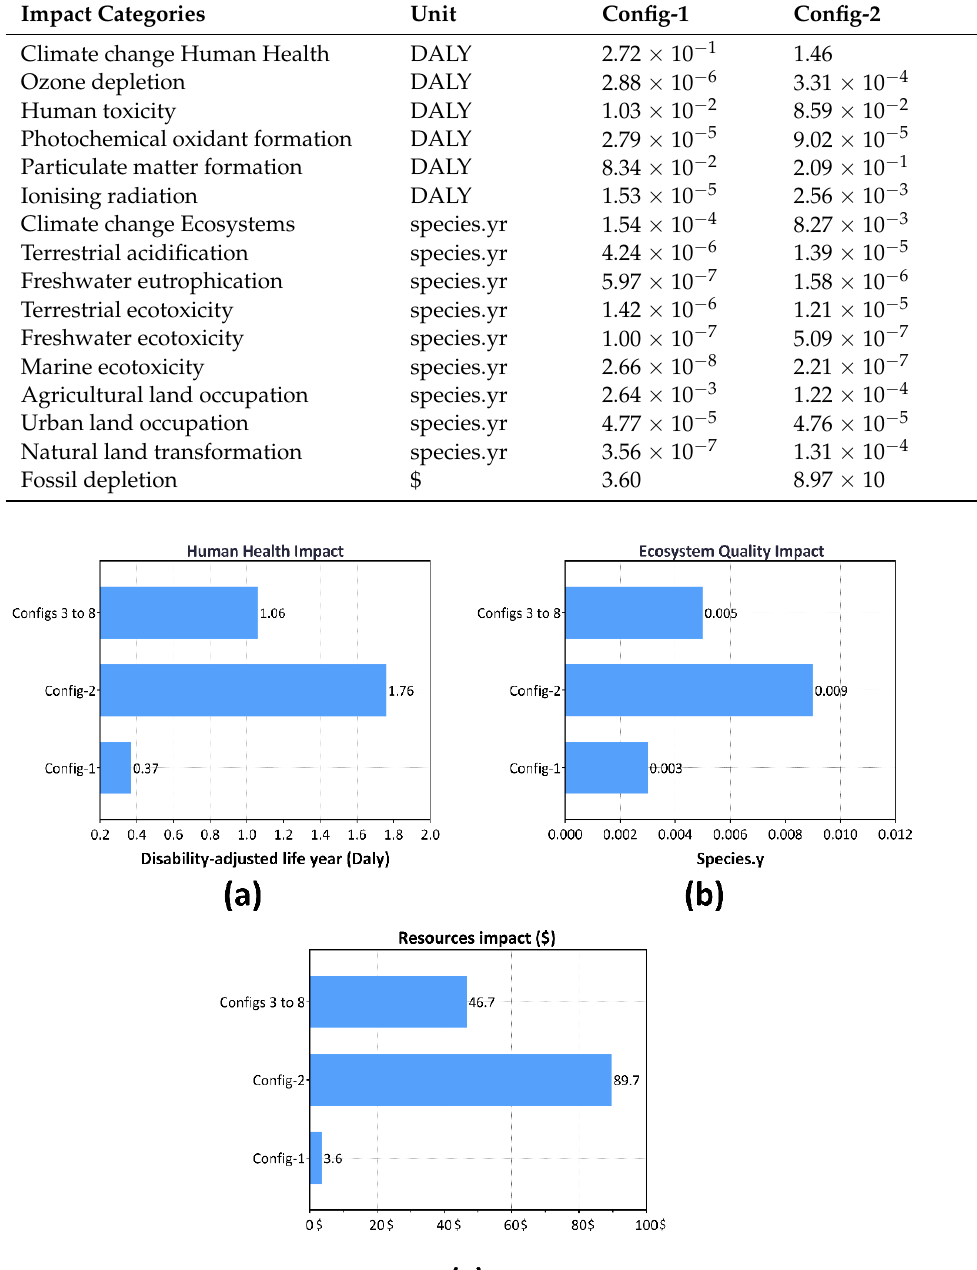
Table 2. Environmental Impacts for Configs 1 to 8.